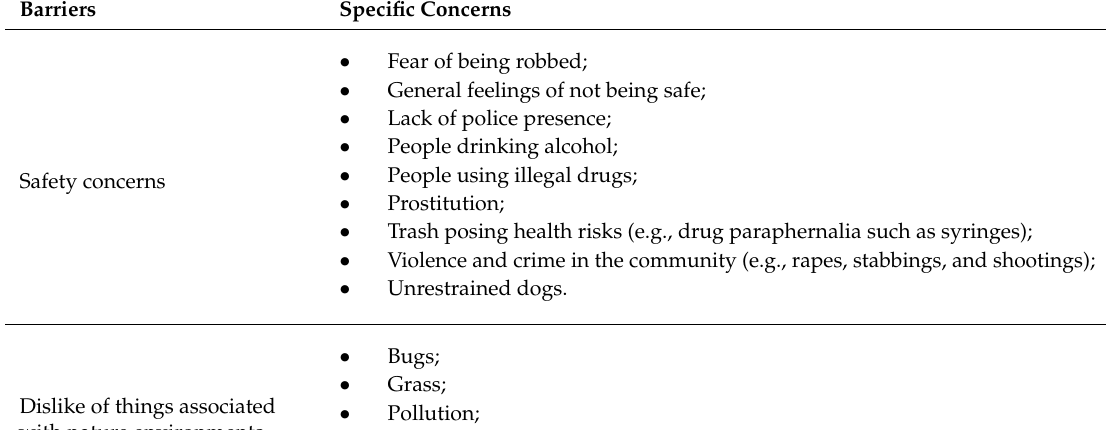
Table 4. Barriers discouraging time spent in